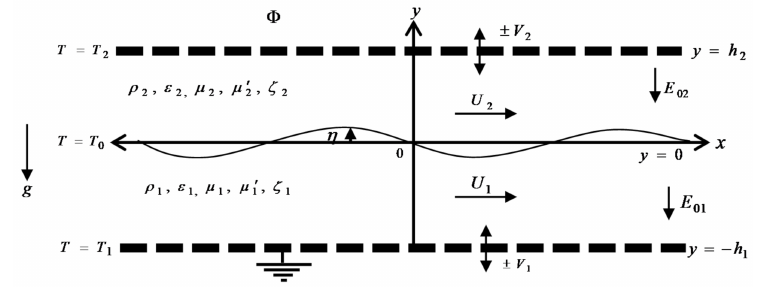
Figure 1. Sketches the theoretical physical